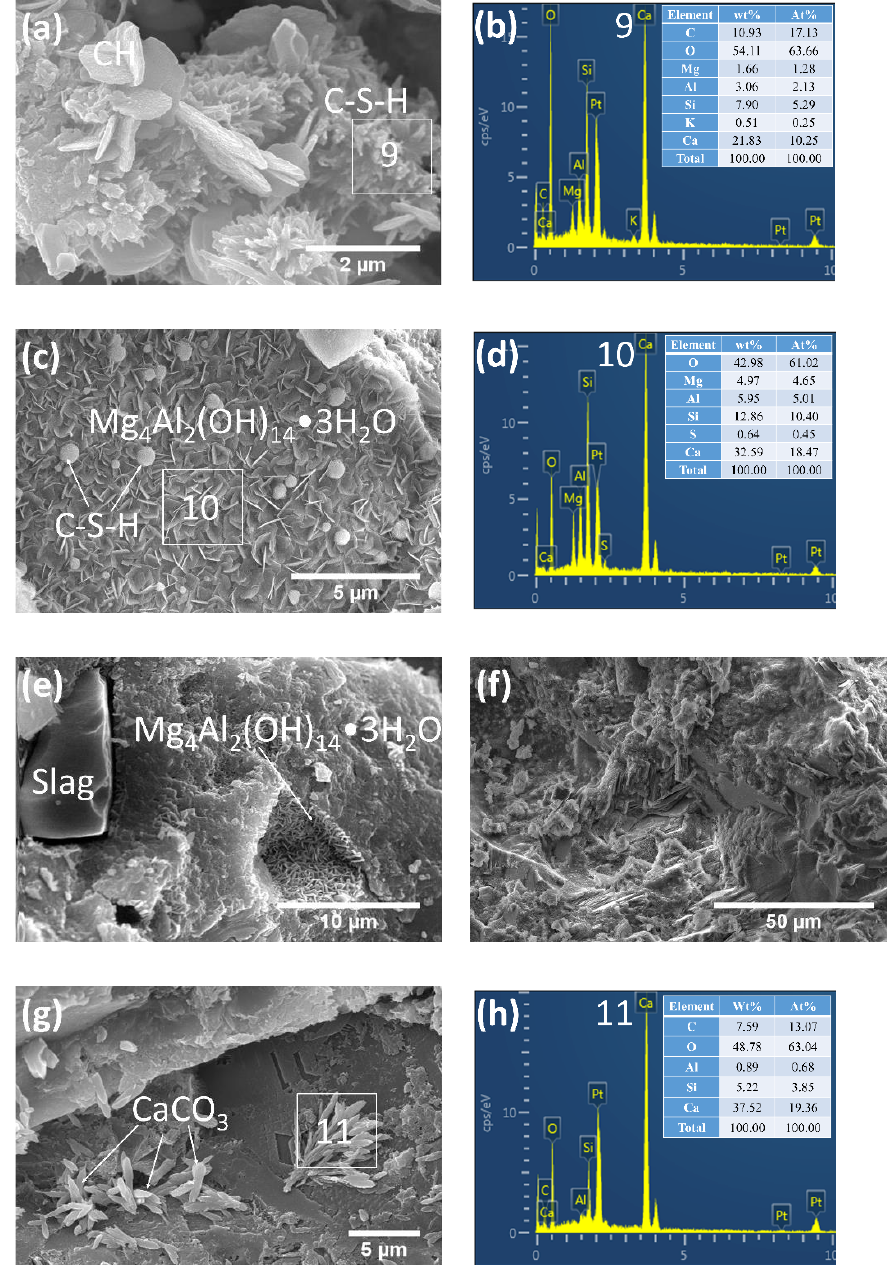
Figure 10. SEM images of cement-GBFS composite binder after standard curing for 28 d, ( a ) fibrous C-S-H gels; ( b ) EDS result of area 9; ( c ) flake-like hydrotalcite and quant grain-shaped C-S-H gels; ( d ) EDS result of area 10; ( e ) flake-like hydrotalcite; ( f ) dense microstructure; ( g ) tadpole-like CaCO 3 ; ( h ) EDS result of area